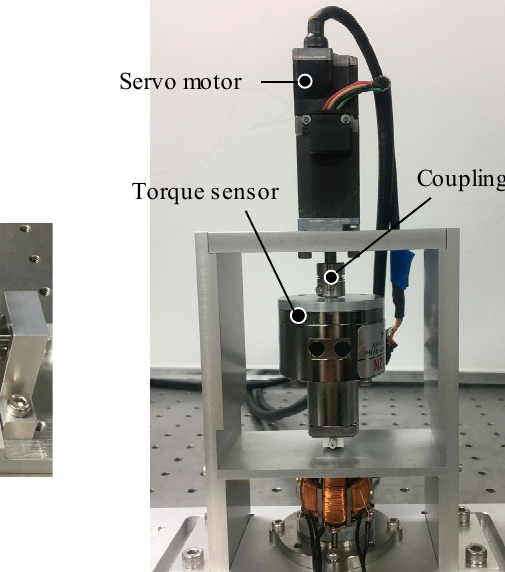
Figure 15. Torque characteristics in the Z -axis.